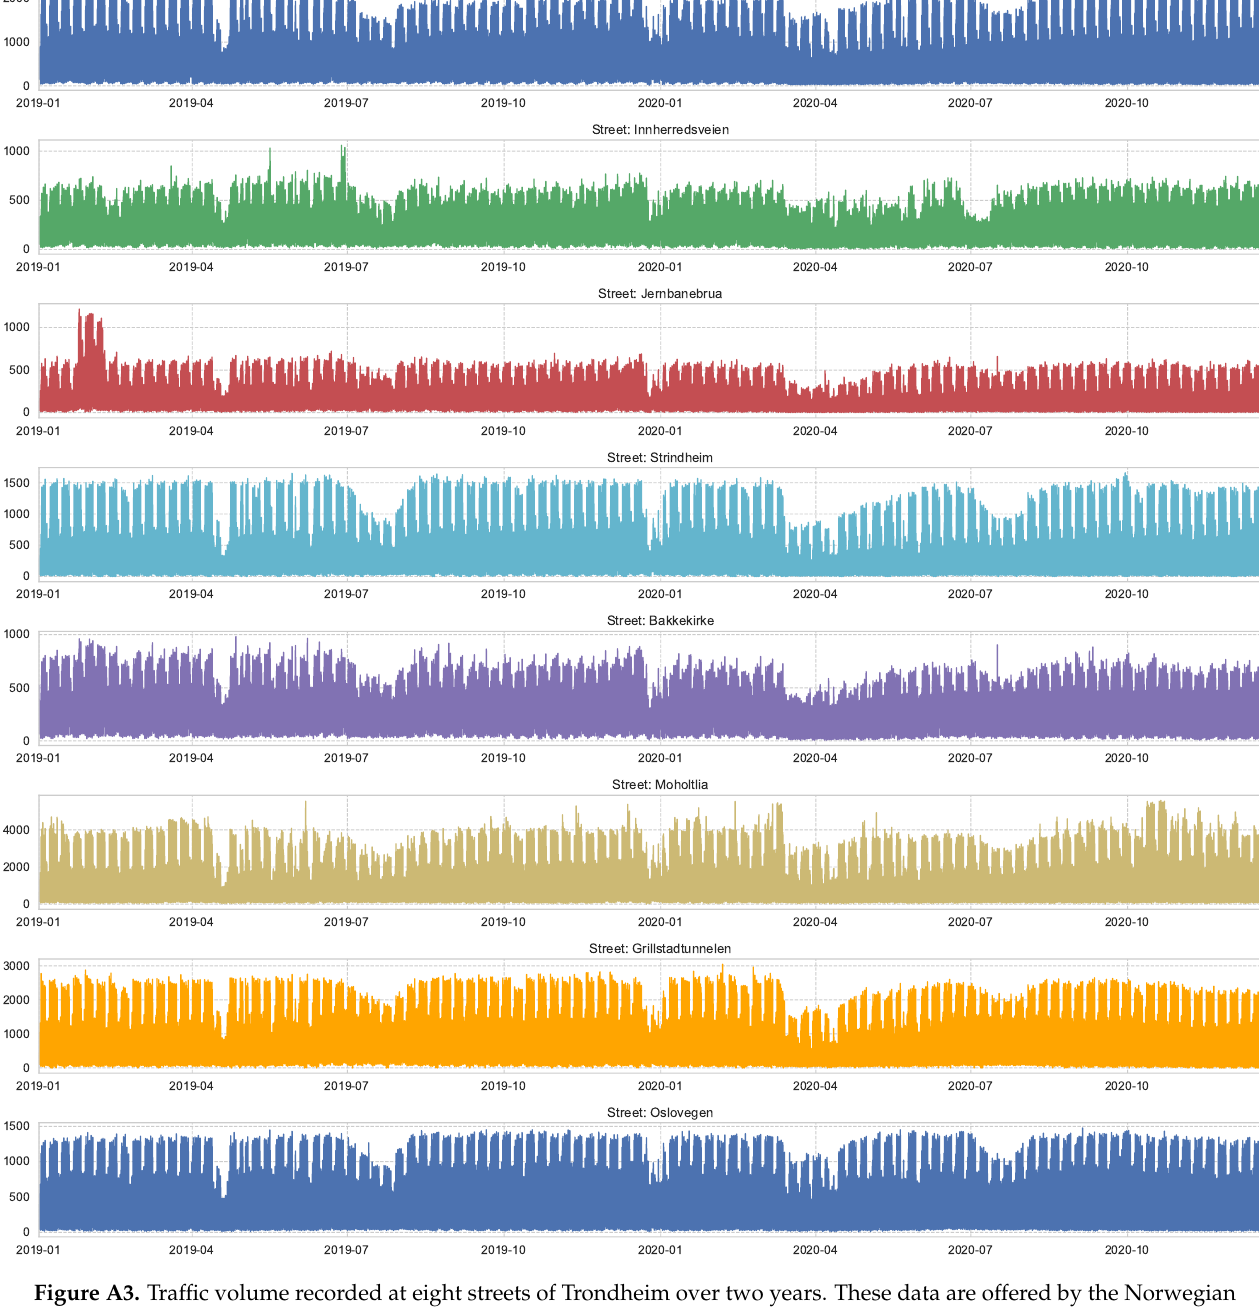
Figure A3. Traffic volume recorded at eight streets of Trondheim over two years. These data are offered by the Norwegian Public Roads Administration (https://www.vegvesen.no/trafikkdata/start/om-api, accessed on 27 November 2021). We also used data of street-cleaning at main streets of Trondheim, as shown in Figure A4. These data are reported by the municipality and include the duration of time in which a street-cleaning is taking